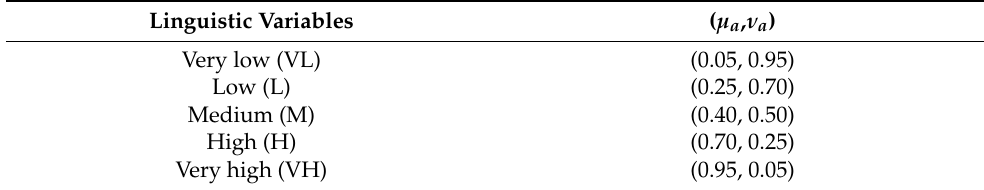
Table 3. Conversion between linguistic variables and ( µ a , ν a ) (after research [44]). Linguistic